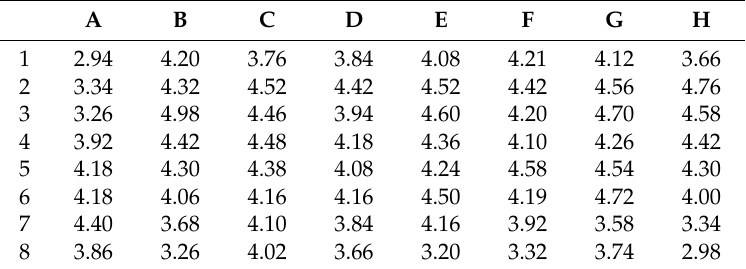
Table A8. Measured values of CO 2 concentration distribution in Experiment A3 (ppm). A